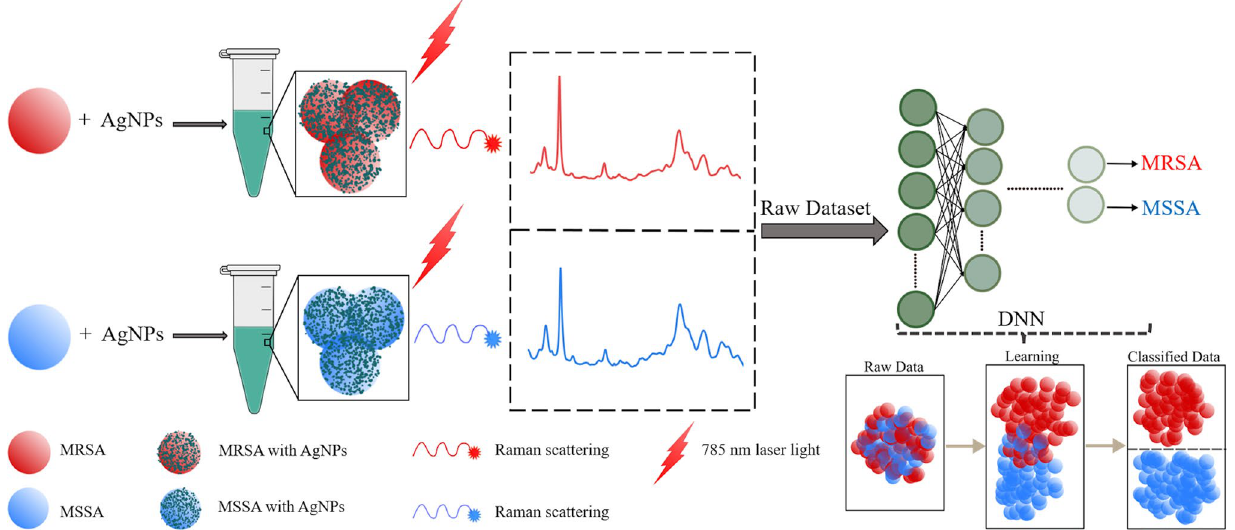
Figure 1. General workflow of deep learning-based spectral data analysis for the discrimination of antibiotic- resistant